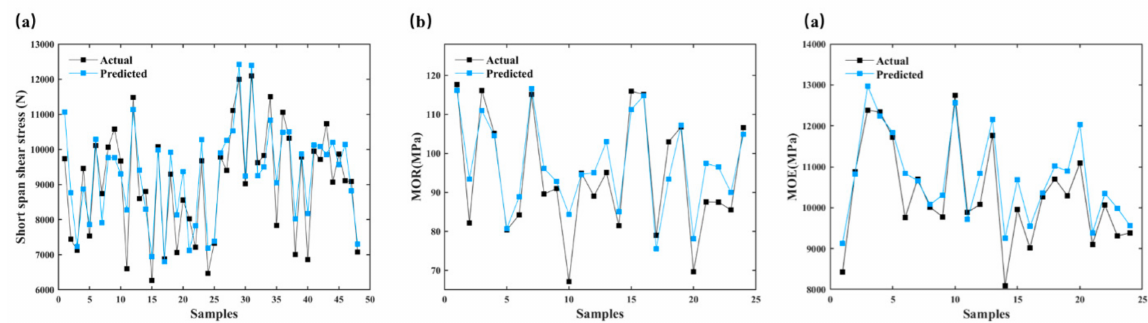
Figure 4. Comparison of the actual and predicted values of testing sets of the SVM models for mechanical properties: ( a ) short-span shear stress, ( b ) MOR, and ( c )